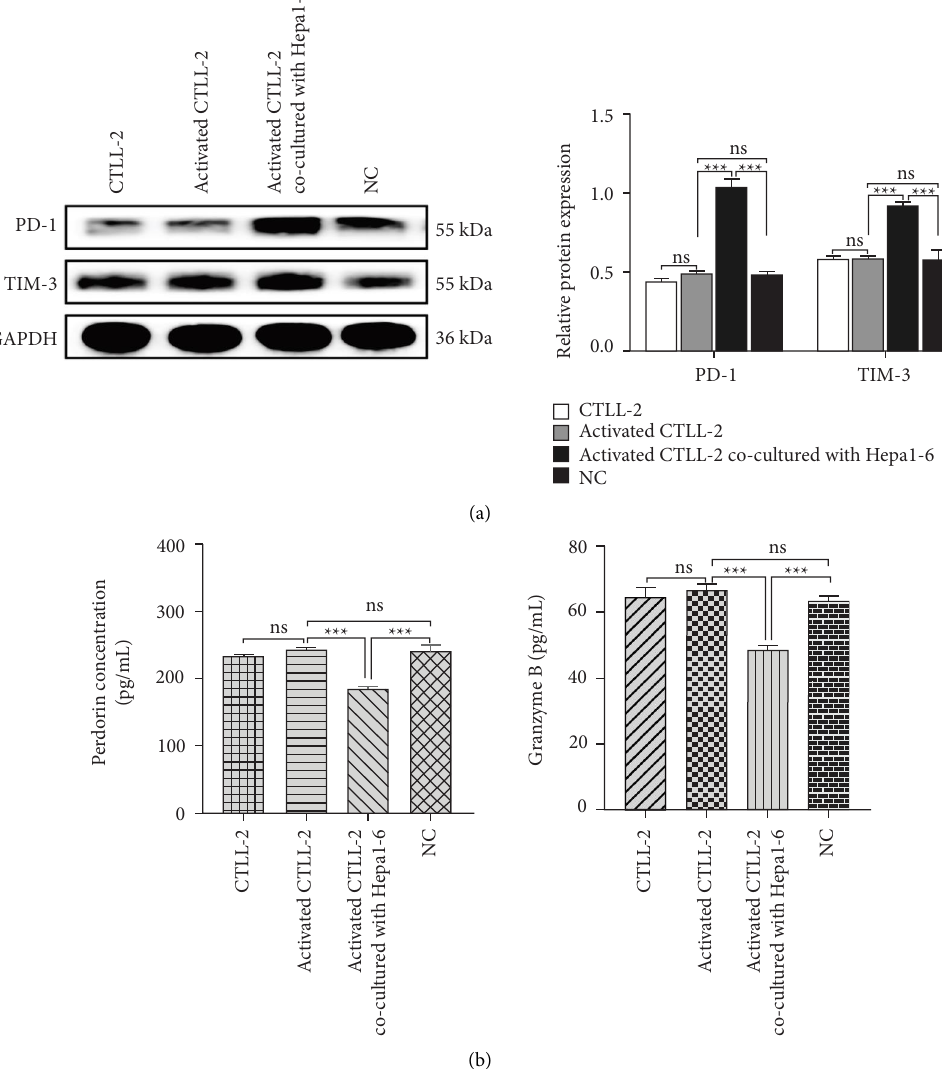
Figure 1: Function of CTLs was induced by hepatoma cells. (a) CTLL-2 cells were cocultured with hepatoma cells. PD-1 and TIM-3 expressions were determined by western blotting analysis. (b) PRF1 and GzmB expression was analyzed by ELISA. Data are presented as the mean ± SD. ∗∗∗ P < 0 . 001, ns indicates no statistical